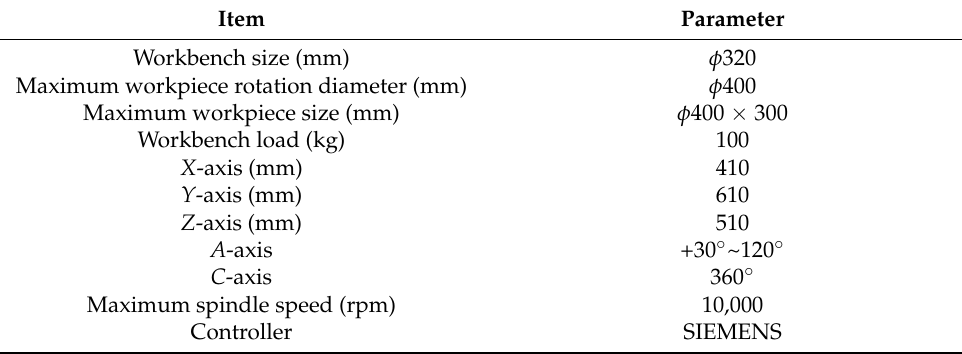
Table 4. Quaser five-axis vertical machining center